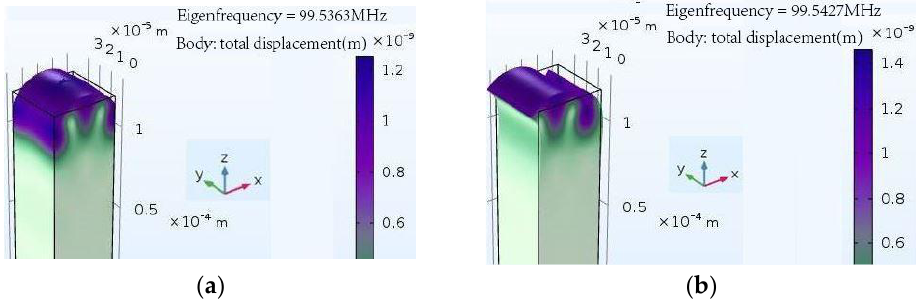
Figure 5. Displacement distribution of the SAW: ( a ) symmetric mode; ( b ) anti-symmetric model.